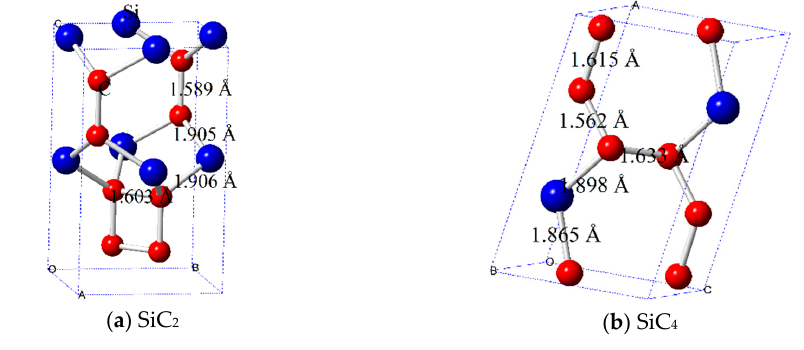
Figure 1. Unit cell crystal structures of SiC 2 ( a ) and SiC 4 ( b ).